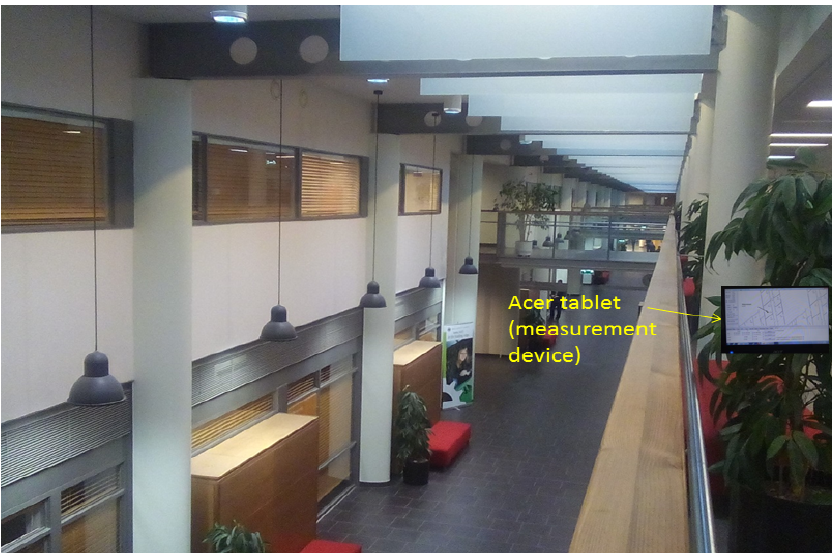
Figure 4. A picture taken from the second floor of